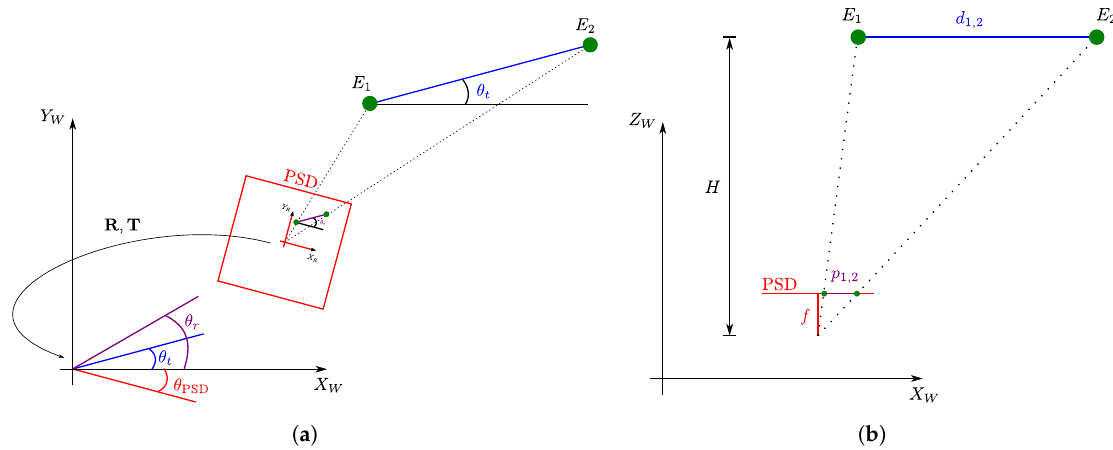
Figure 3. ( a ) Method for obtaining the angle θ PSD . ( b ) Method for obtaining the H separation between the emitter plane and the PSD